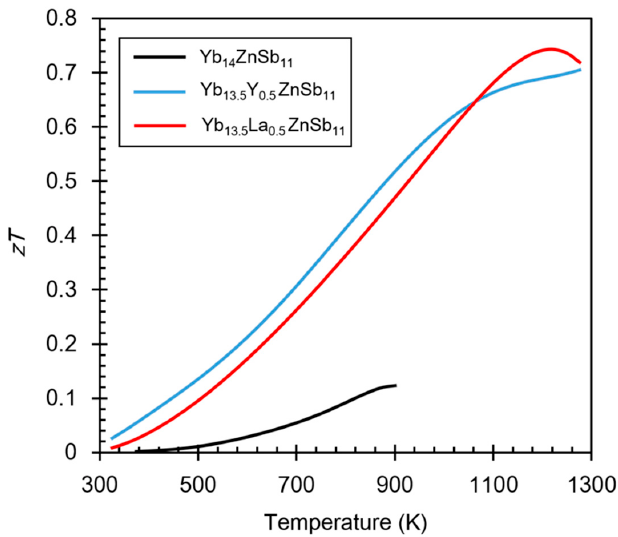
Figure 6. Calculated zT for the Yb 13.5 RE 0.5 ZnSb 11 (RE = Y, La) compounds compared with that of Yb 14 ZnSb 11 (data from the work of [9]).